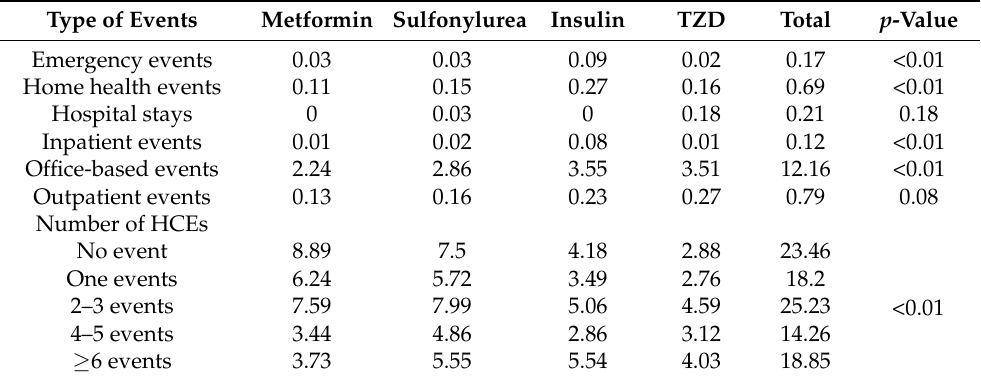
Table 5. The mean number of healthcare-associated events in diabetes patients across different treatments.